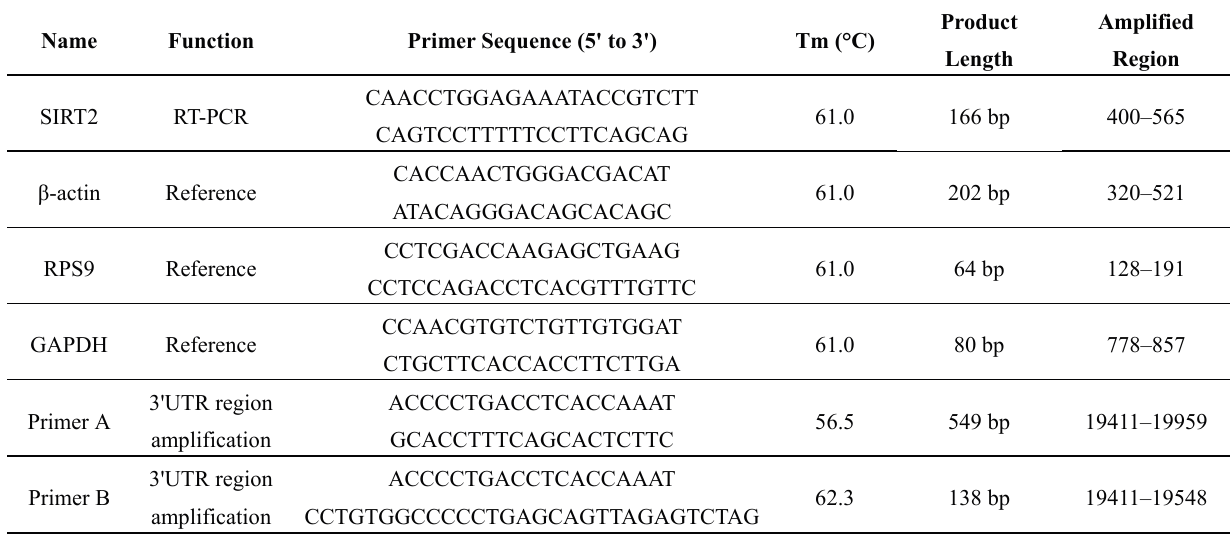
Table 6. Primers used in these